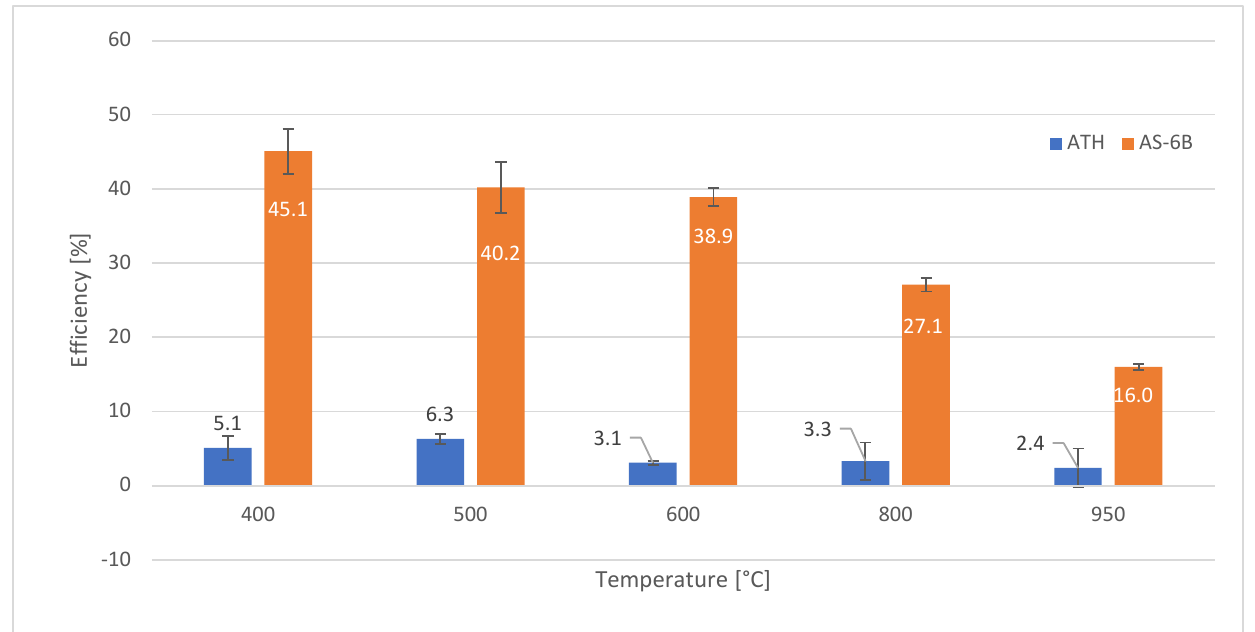
Figure 4. Efficiency % (T) of formulation F50.1 (blue) and F50.5 (orange) as a function of temperature. Standard deviation ranges are reported. ATH stands for Al(OH) 3.